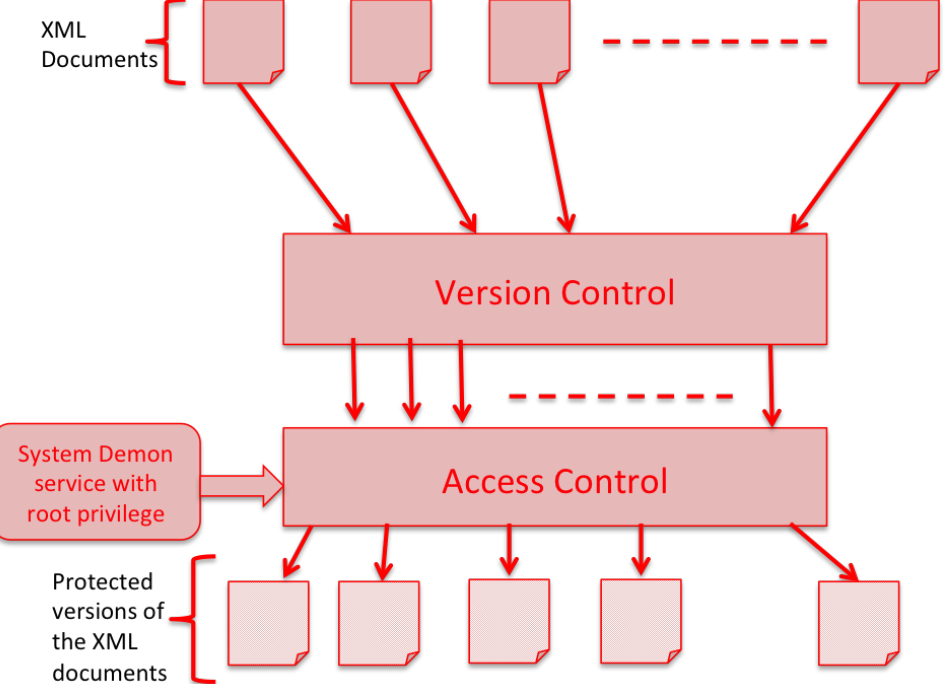
Figure 1. The overall architecture of SH-VARR